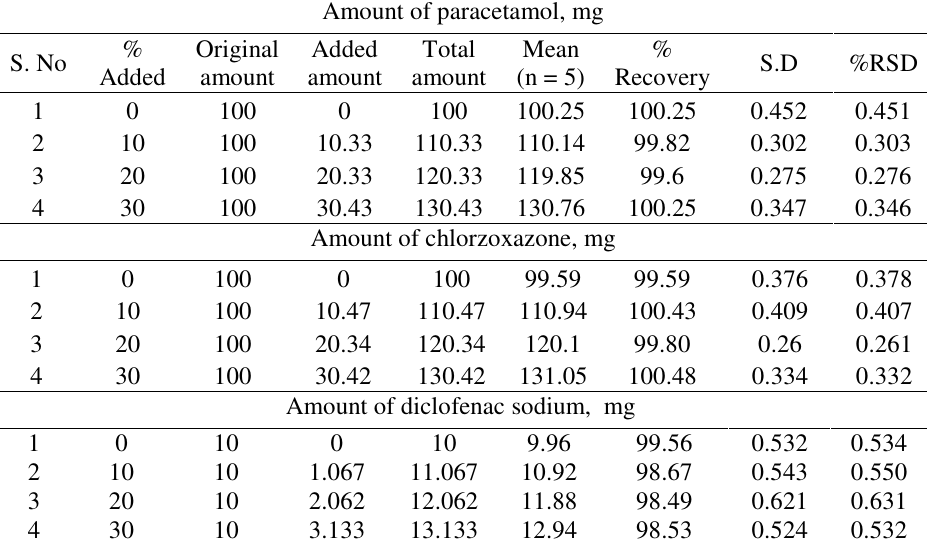
Table 1 . % Recovery of paracetamol, chlorzoxazone and diclofenac sodium Amount of paracetamol,